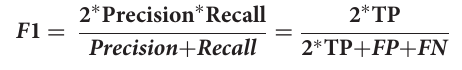
ROC Curve is the rate of true positives against false